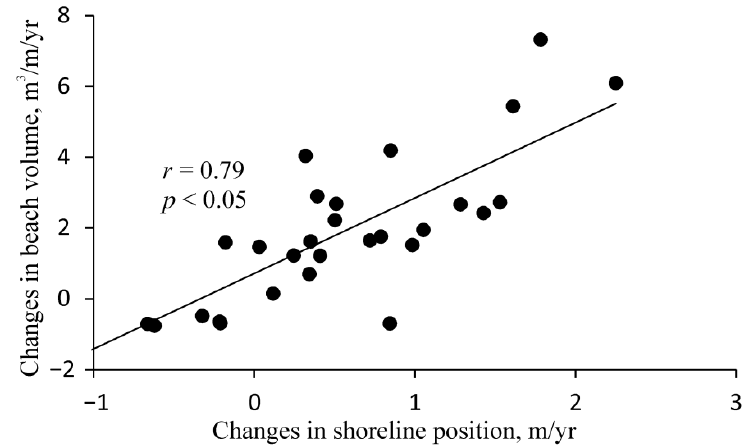
Figure 7. Correlation between mean changes in the shoreline position and beach sand